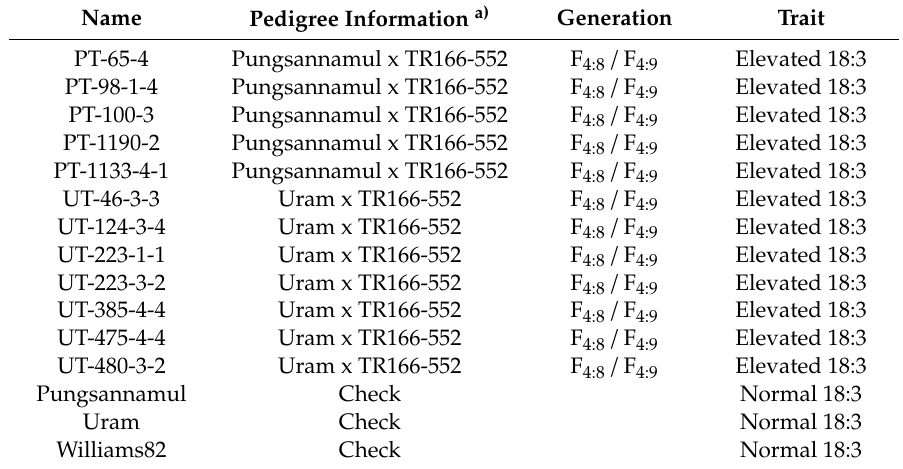
Table 1. Nomenclature, pedigree, generation, and trait information for soybean accession used in this